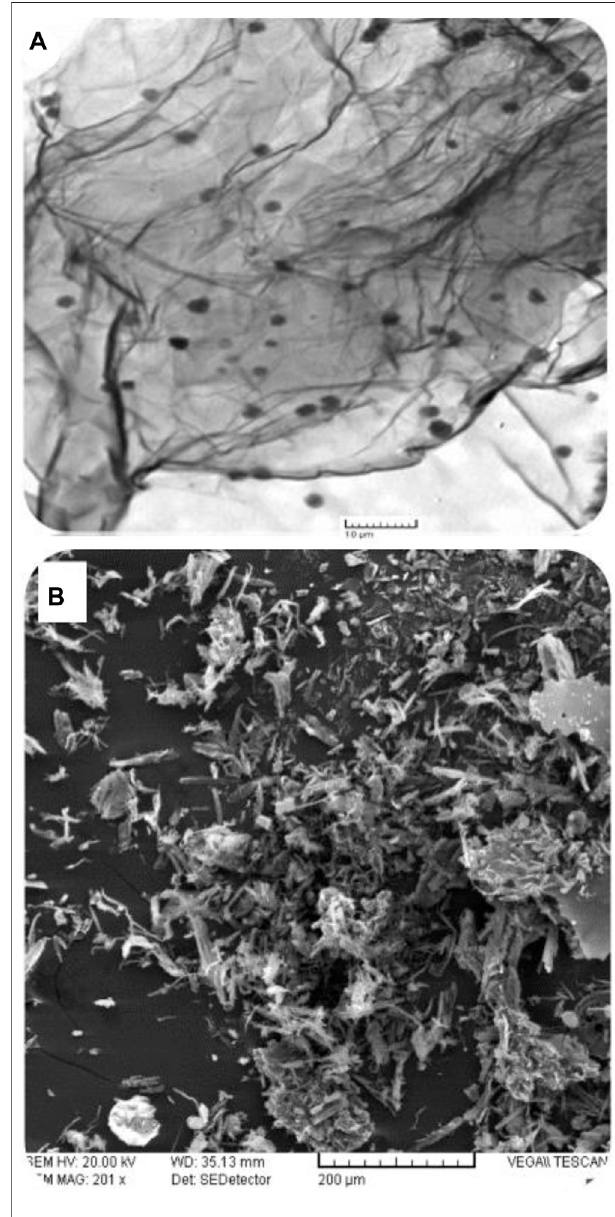
FIGURE 3 | Microscopic characterization: (A) TEM micrograph of poly- CoTAPc-CoTCPc-GONS; (B) SEM image of poly-CoTAPc-CoTCPc- GONS/GCE.